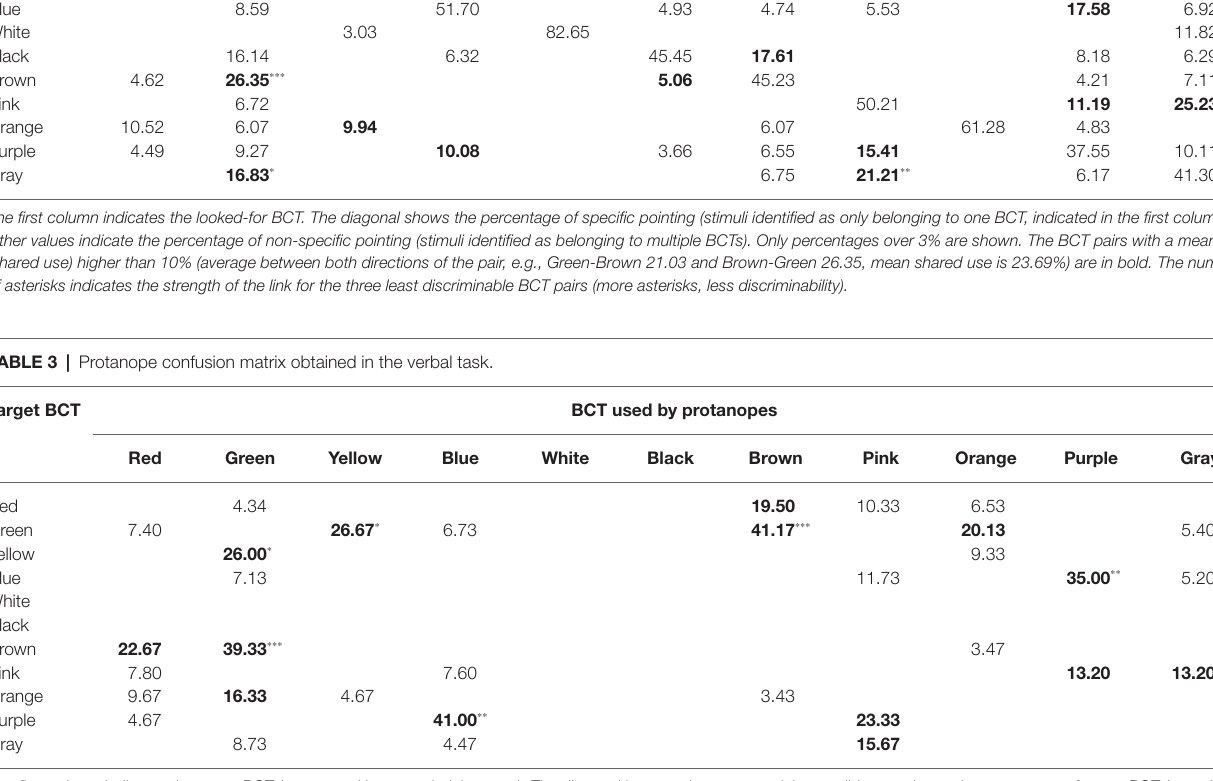
TABLE 2 | Deuteranope confusion matrix obtained in the pointing task. Looked-for BCT